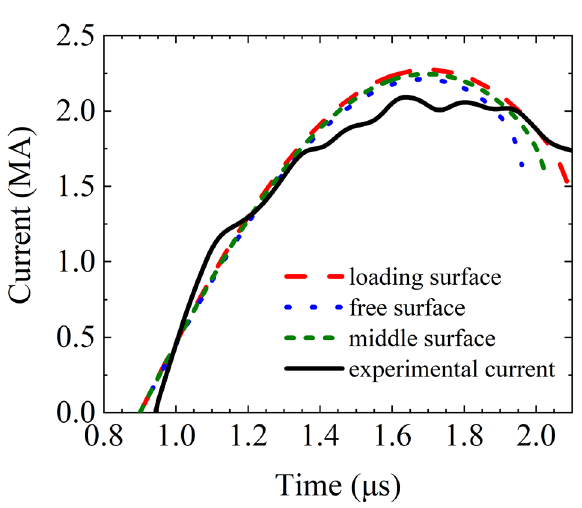
Figure 9. Calculated load current curves for the thin-shell model for different initial radial positions as the characteristic